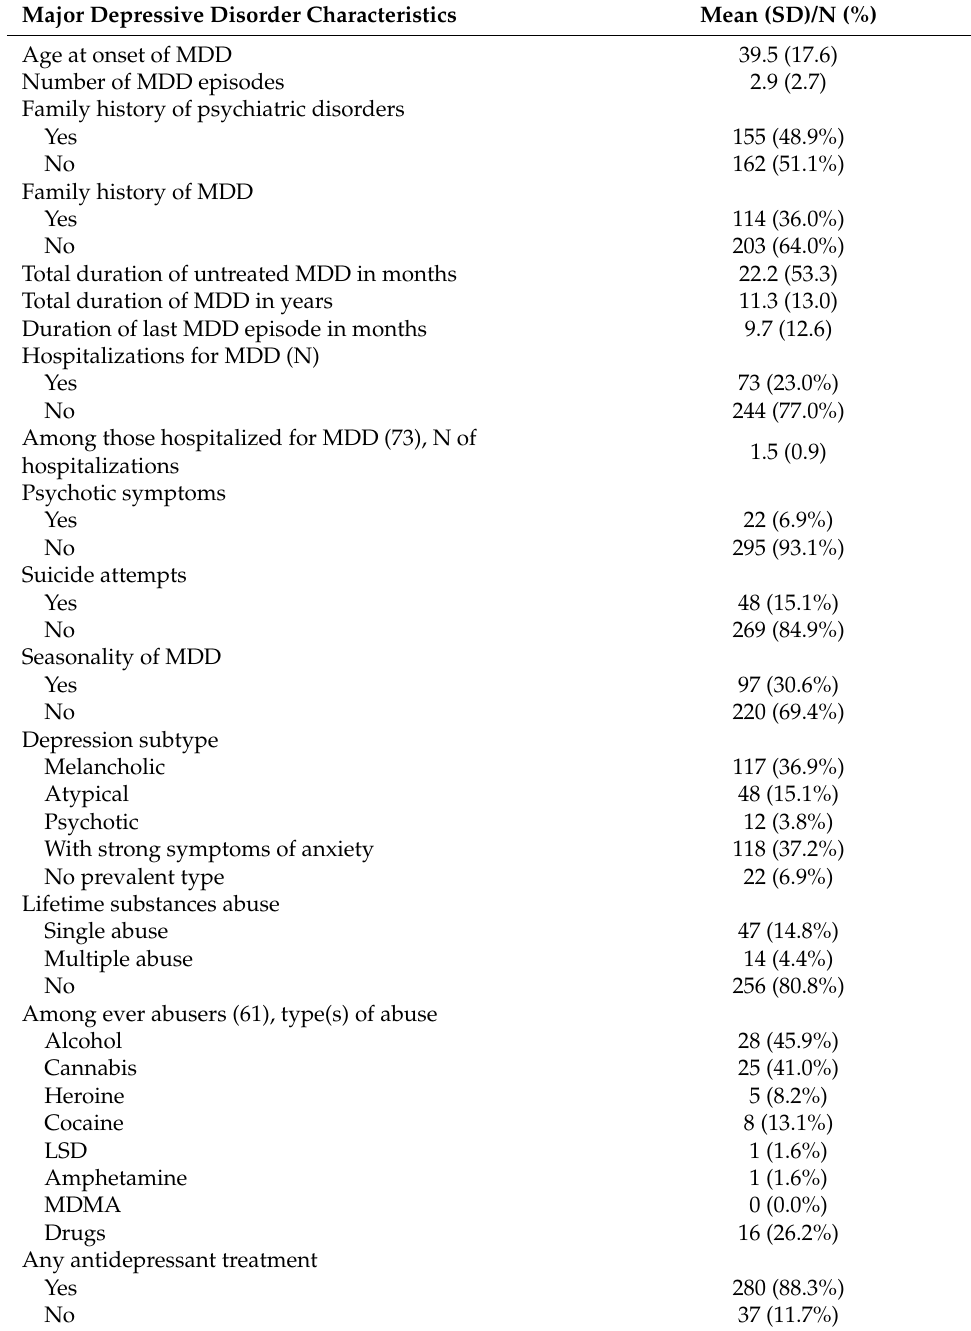
Table 2. MDD characteristics in 317 study subjects recruited until 1 July